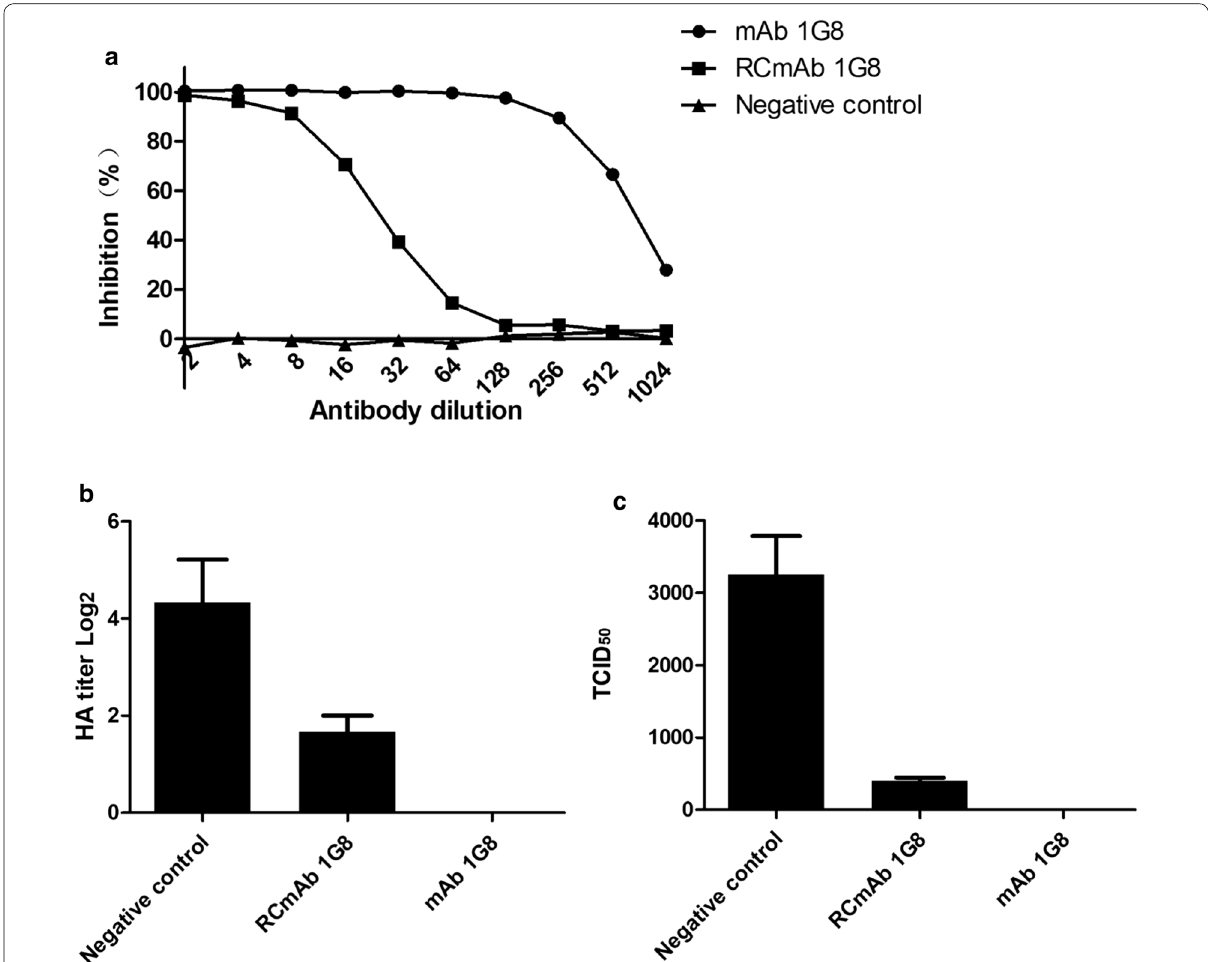
Fig. 3 Inhibitory effect and neutralizing ability of the RCmAb 1G8 against NA. a Inhibition of NA activity measured via ELLA. RCmAb 1G8 was diluted from 2 − 1 to 2 − 10 and incubated with X1 virus. Purified mAb 1G8 at initial concentration of 20 µg/mL was used as positive control. The supernatant of COS-1 cells transfected with pCAGGS was used as negative control. b HA titer and c TCID 50 of X1 virus in MN assay incubated with RCmAb 1G8. mAb 1G8 at concentration of 5 µg/mL was used as positive control. The supernatant of COS-1 cells transfected with pCAGGS was used as negative